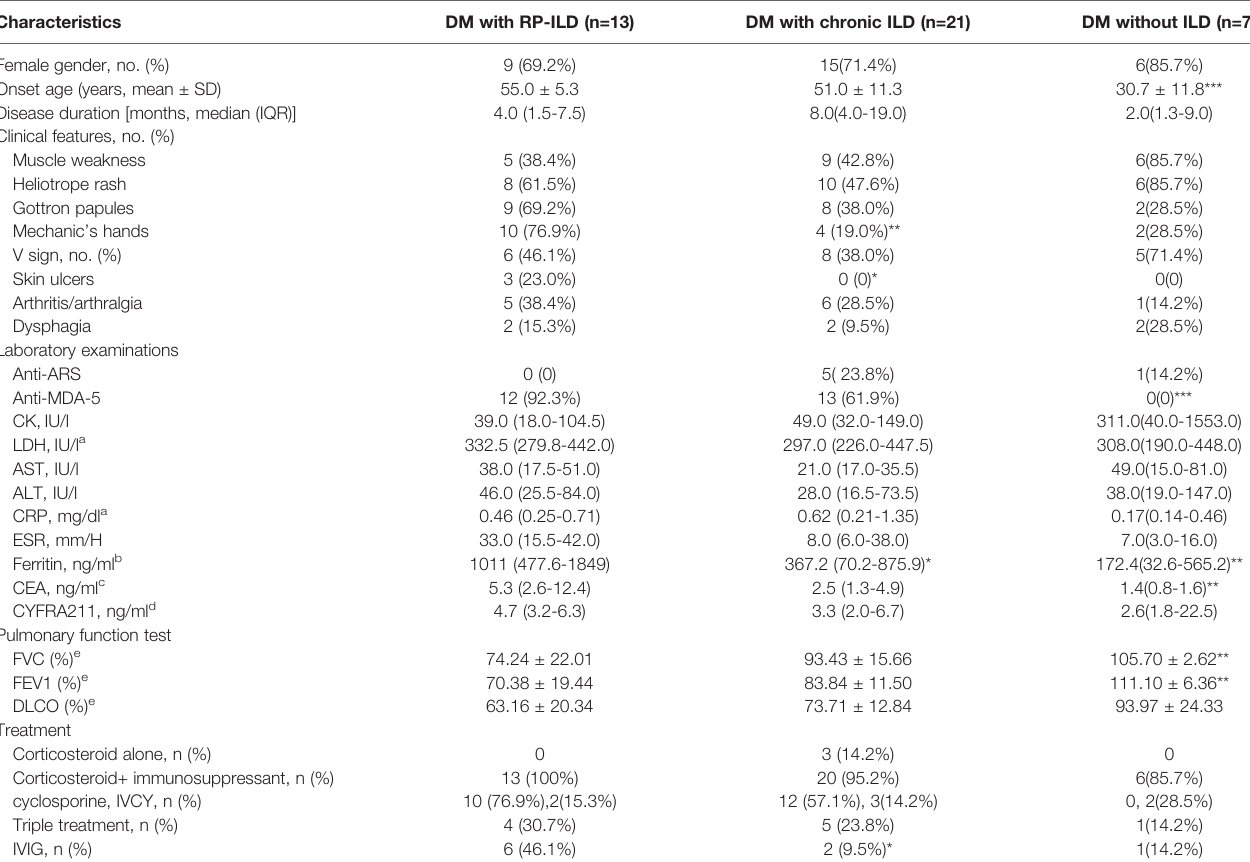
TABLE 1 | Clinical and laboratory characteristics of DM patients with vs without RP-ILD.